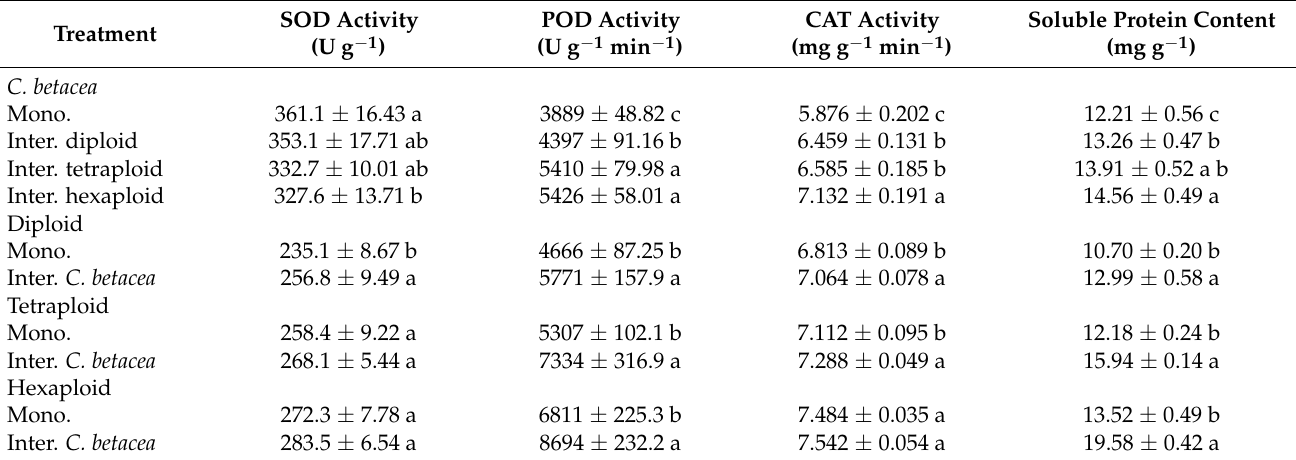
Table 2. Antioxidant enzyme activities and soluble protein contents of